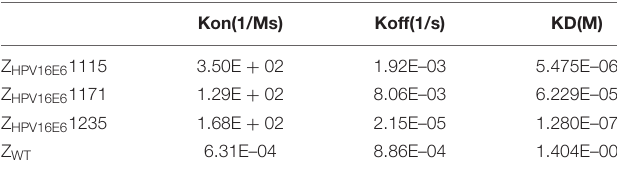
TABLE 1 | Kinetic data from the SPR biosensor analysis of the Affibody